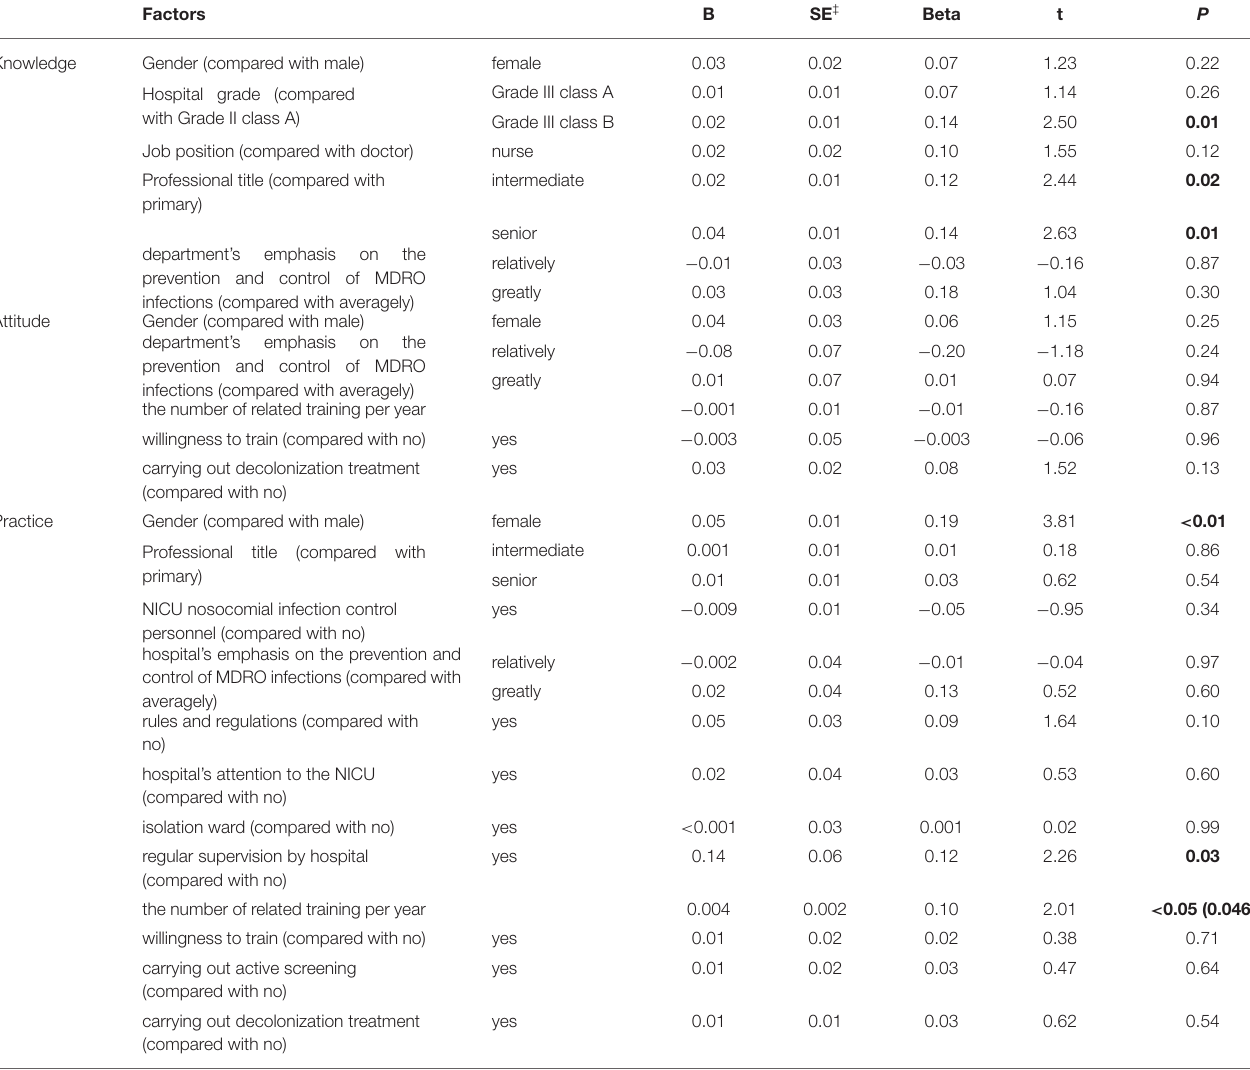
TABLE 4 | Multiple regression of the KAP †